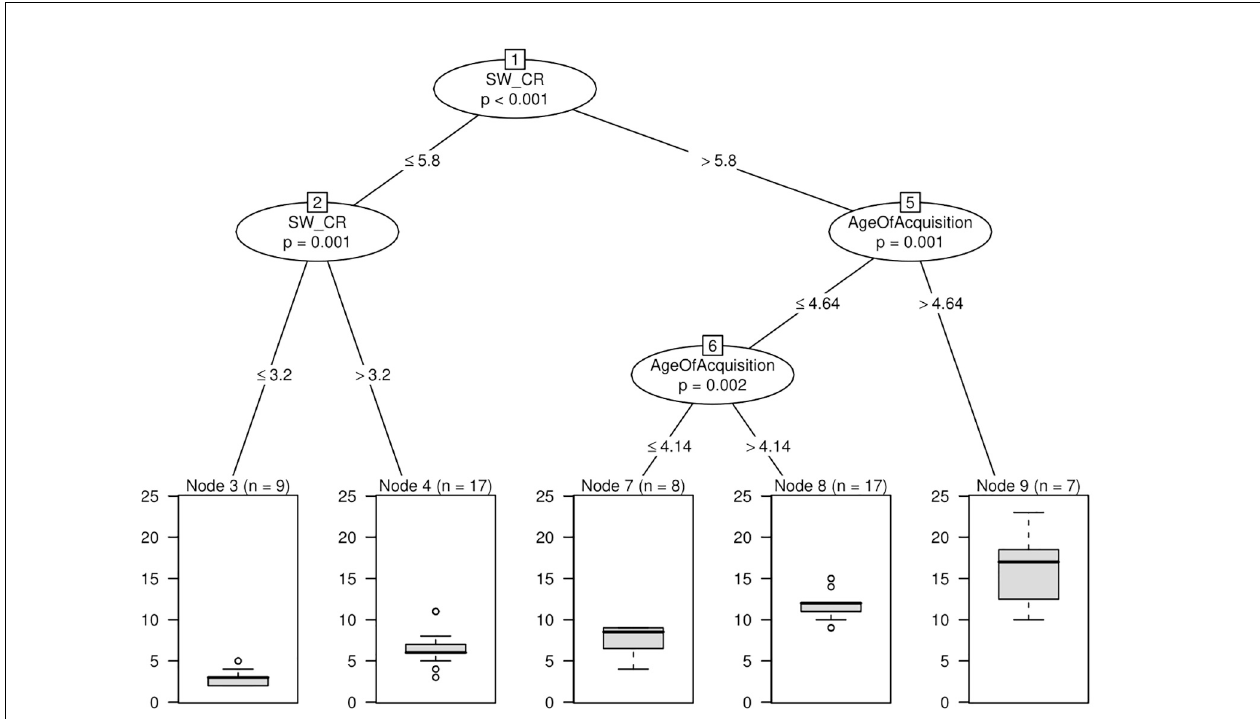
FIGURE 1 | Conditional inference tree with switches and age of acquisition as relevant variables. Conditional inference tree representing how variables interact. Each circle or box represents a node. The number of each node is written on top of the circle or box. Nodes represented with circles show variables that are significantly associated with different distributions of the value of the dependent variable, total number of words , and include a p -value. Below each circle, the values indicate a point in each variable where individuals split into those groups. The nodes represented by boxes are the terminal nodes, which describe a subsection of the sample that corresponds to that split in the data and provides a plot representing the distribution of the data for each subsection of the sample. SW_CR, Switches Correct.